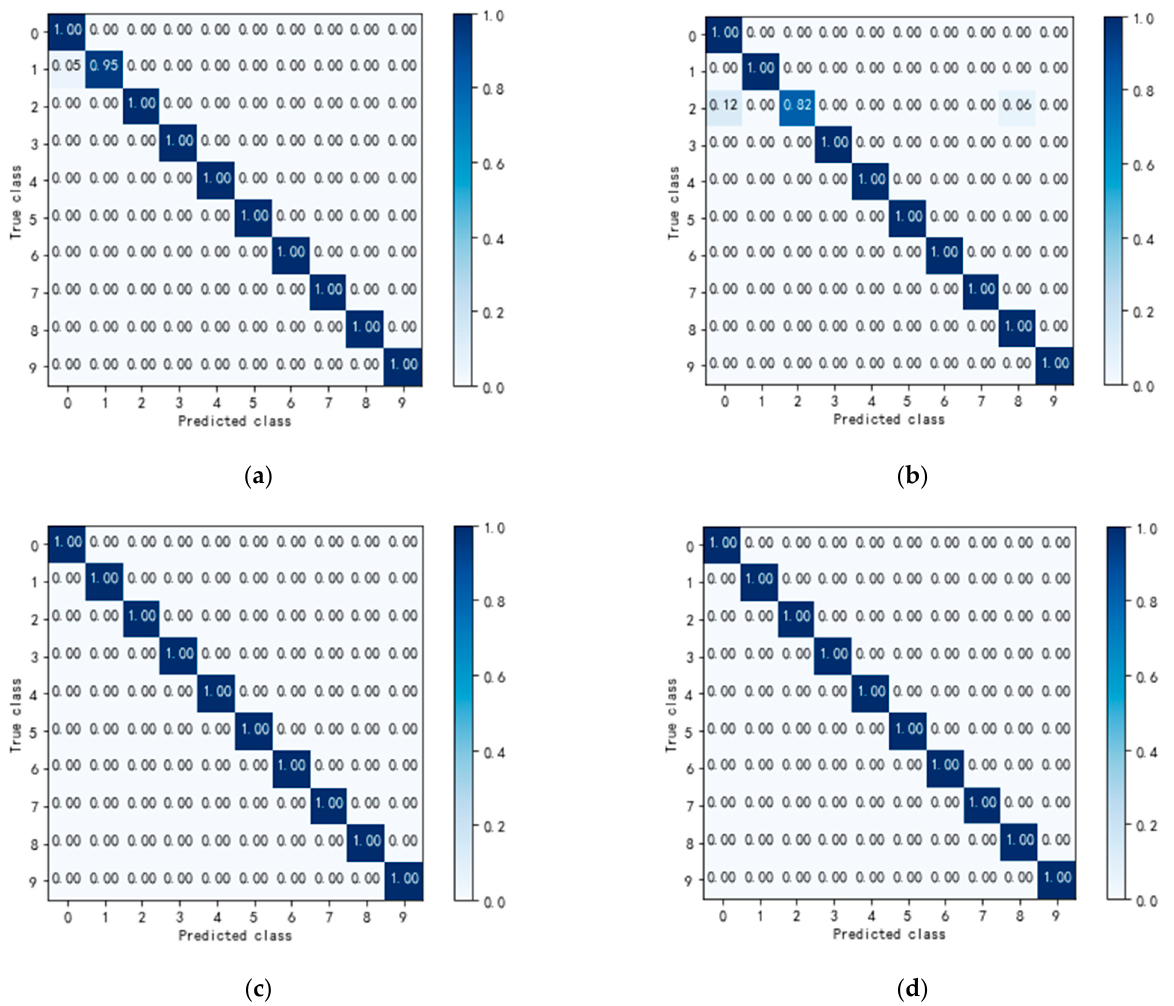
Figure 14. Confusion matrix under different loads ( a ) 0 HP, ( b ) 1 HP, ( c ) 2 HP, and ( d ) 3 HP.